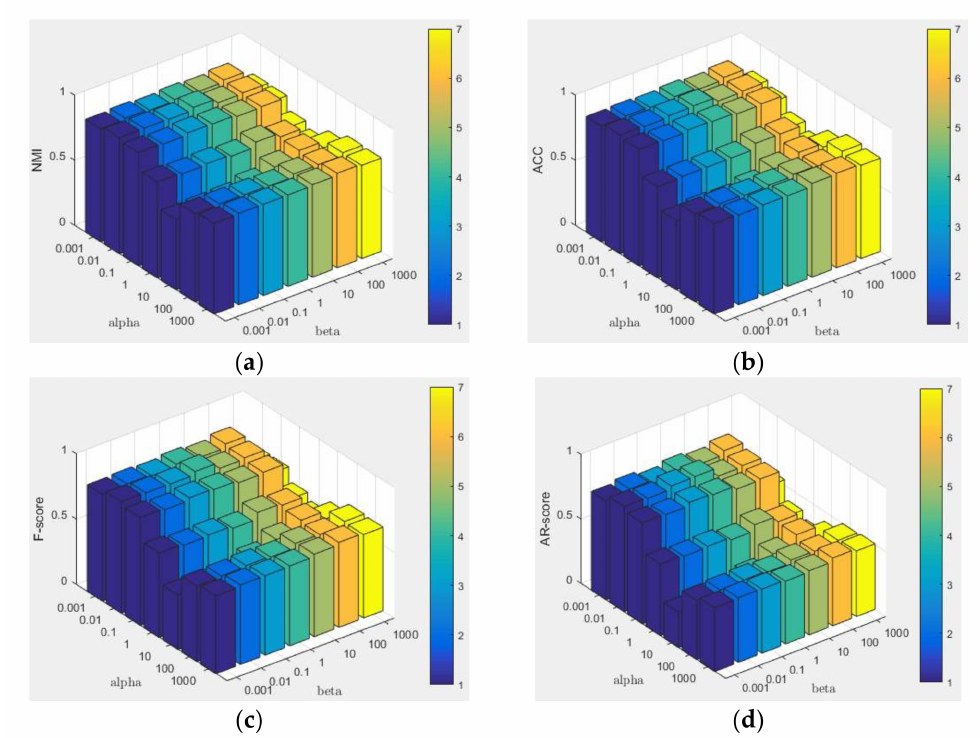
Figure A3. Sensitivity test on alpha and beta versus four metrics on Yale. ( a ) NMI, ( b ) ACC, ( c ) F-score, ( d )